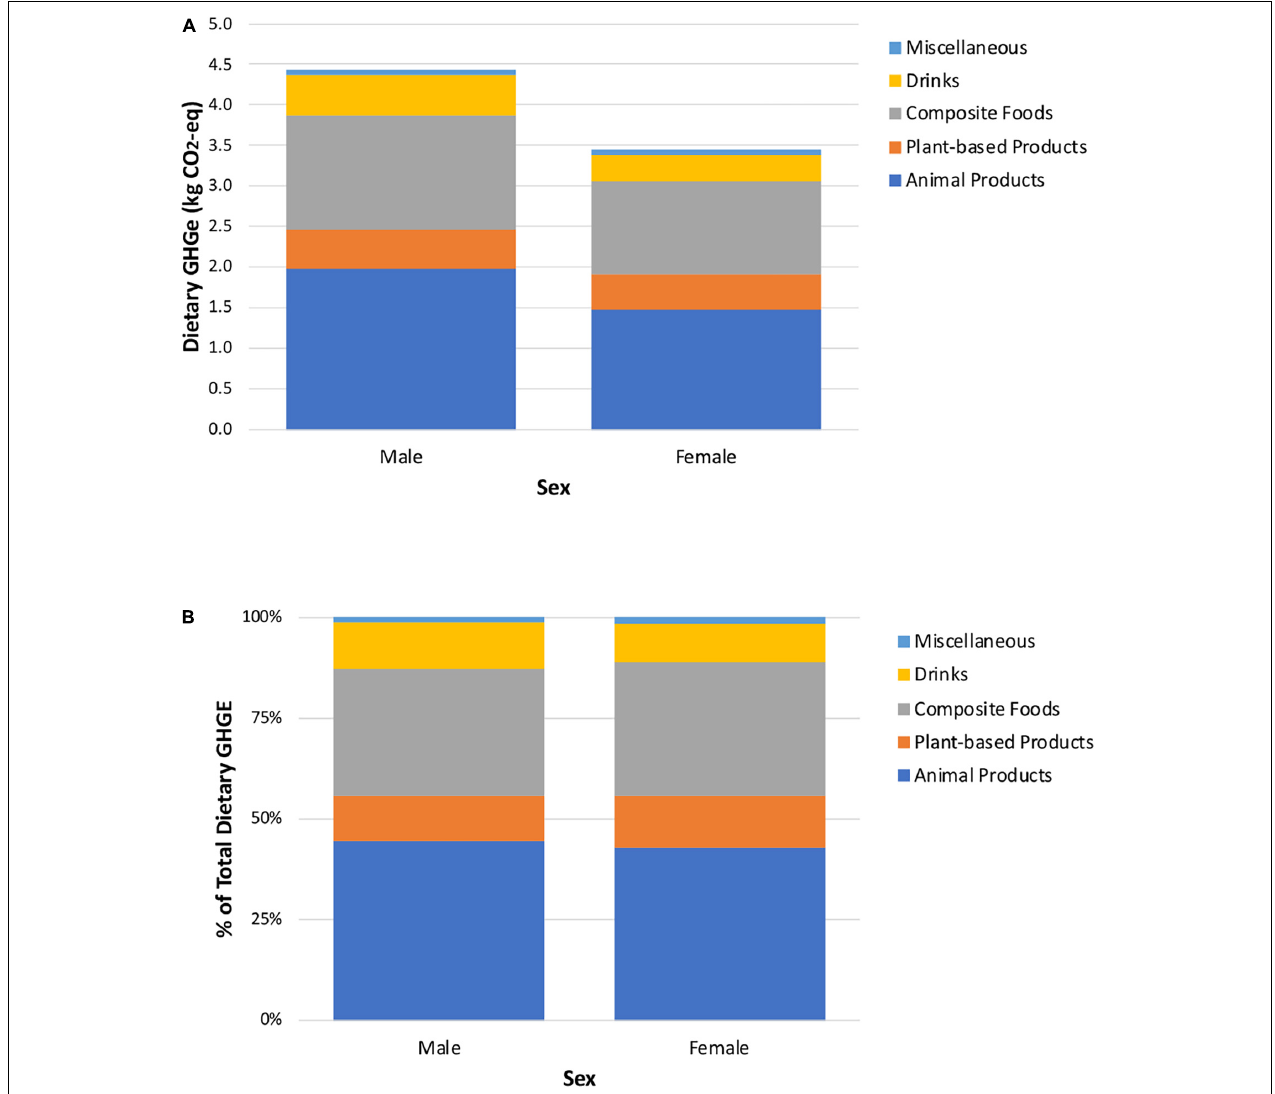
FIGURE 2 | Absolute (A) and relative (B) contribution of each aggregated food and beverage group to total dietary greenhouse gas emissions, stratified by